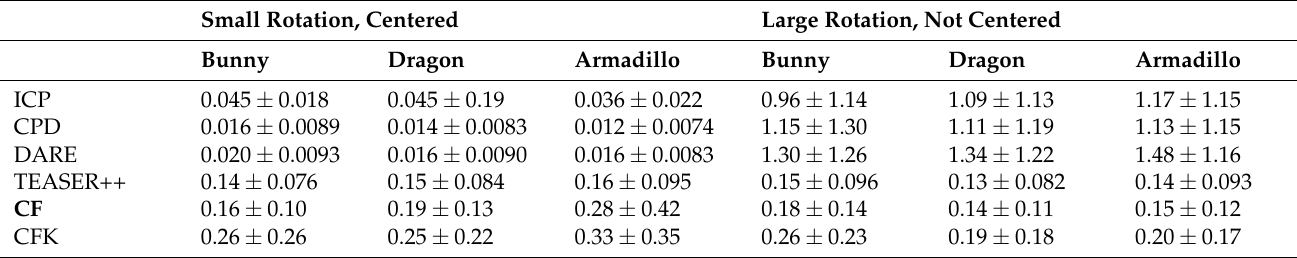
Table A2. Accuracy test: smaller is